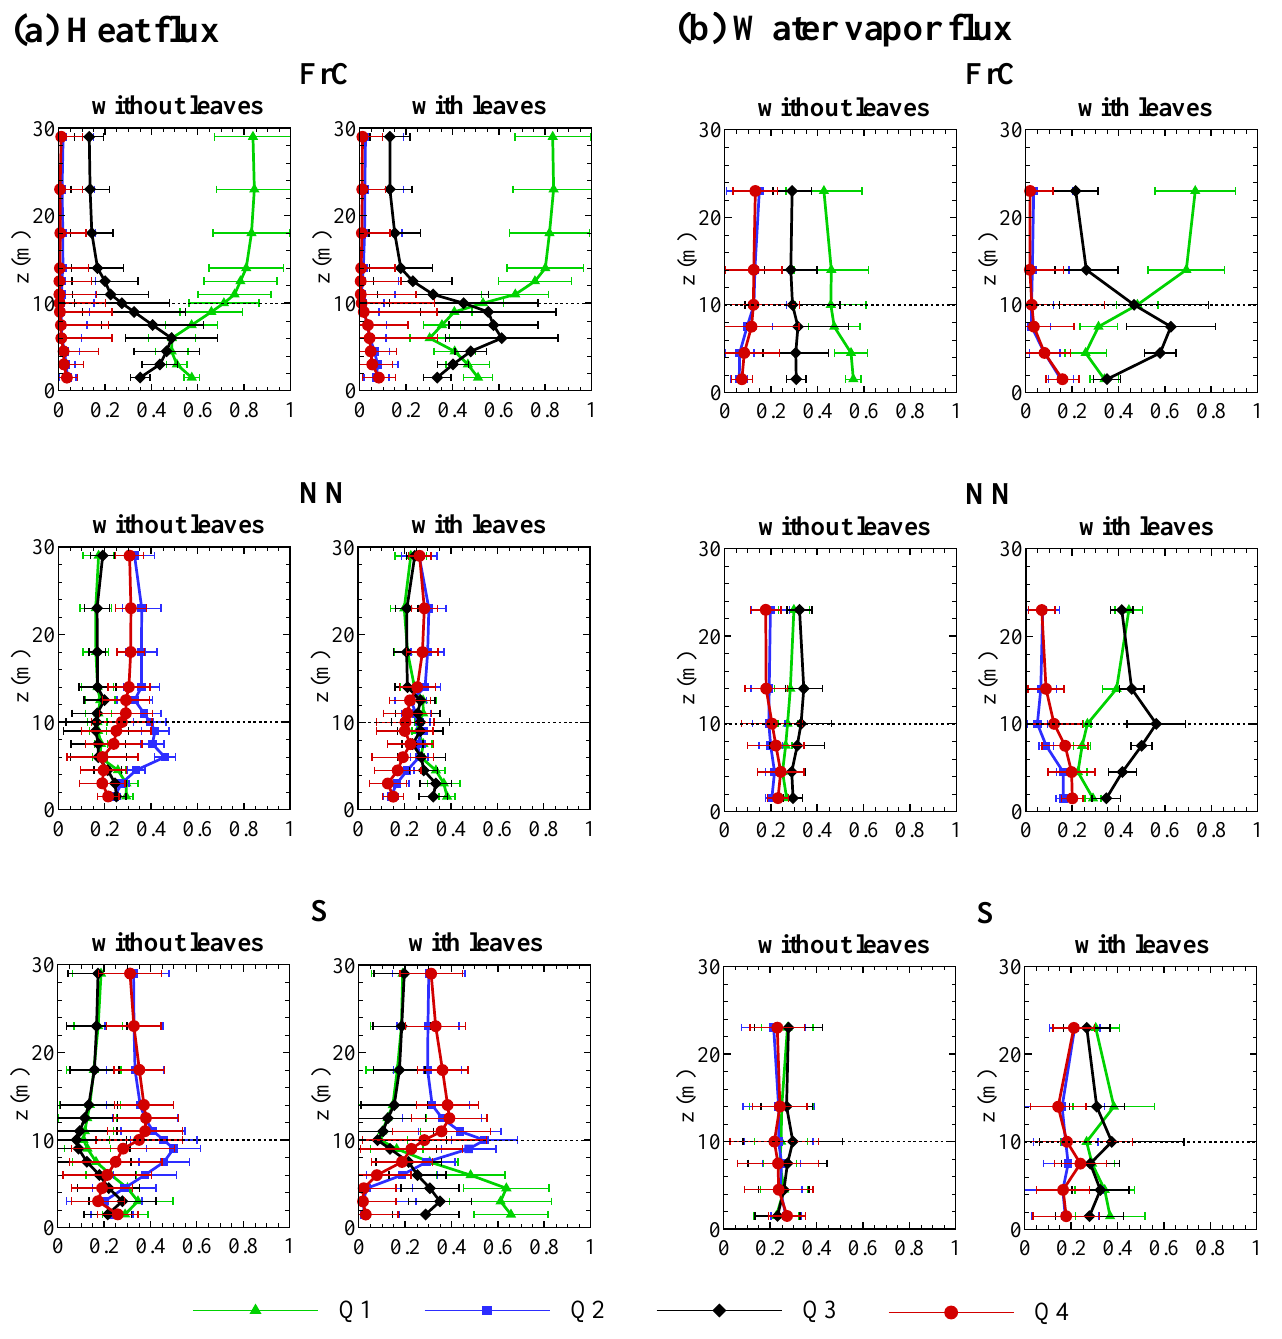
Fig. 4. Fraction of the (a) heat flux h w 0 t 0 i and (b) water vapor flux h w 0 q 0 i in each quadrant as defined in Eq. (4) for the three main stability regimes (FrC, NN and S) and the two seasonal periods. The quadrants are defined in Table 2. Error bars indicate the standard deviation of the fractions. The dashed line indicates the canopy